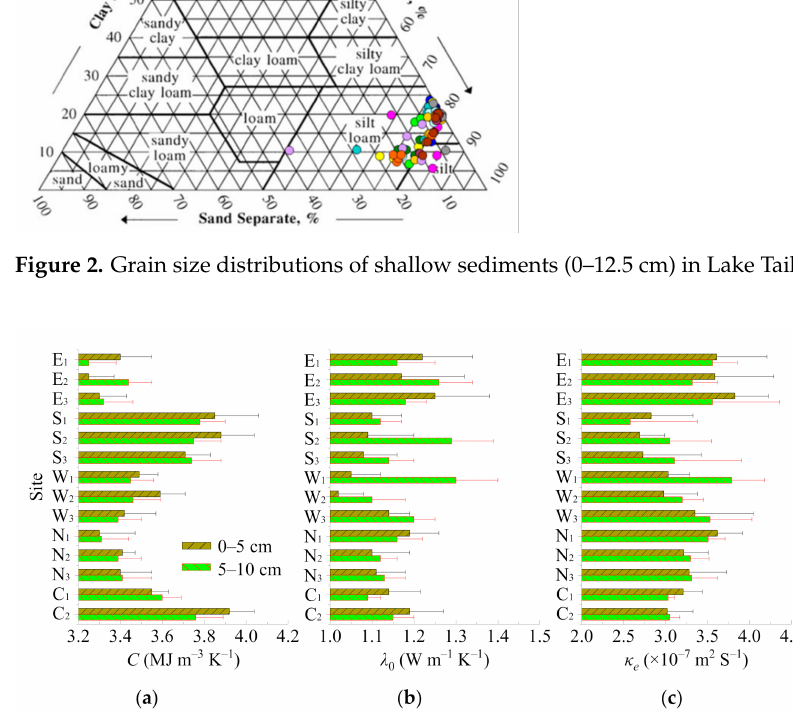
Figure 3. ( a ) In situ measured mean bulk heat capacity ( C ), ( b ) thermal conductivity ( λ 0 ), and ( c ) thermal diffusivity ( κ e ) of saturated sediments at the eastern, southern, western, northern, and central zones of Lake Taihu. Data are given as mean ± SD (measured times for each sample n = 3–5), and only one-half of one standard deviation on one site shows